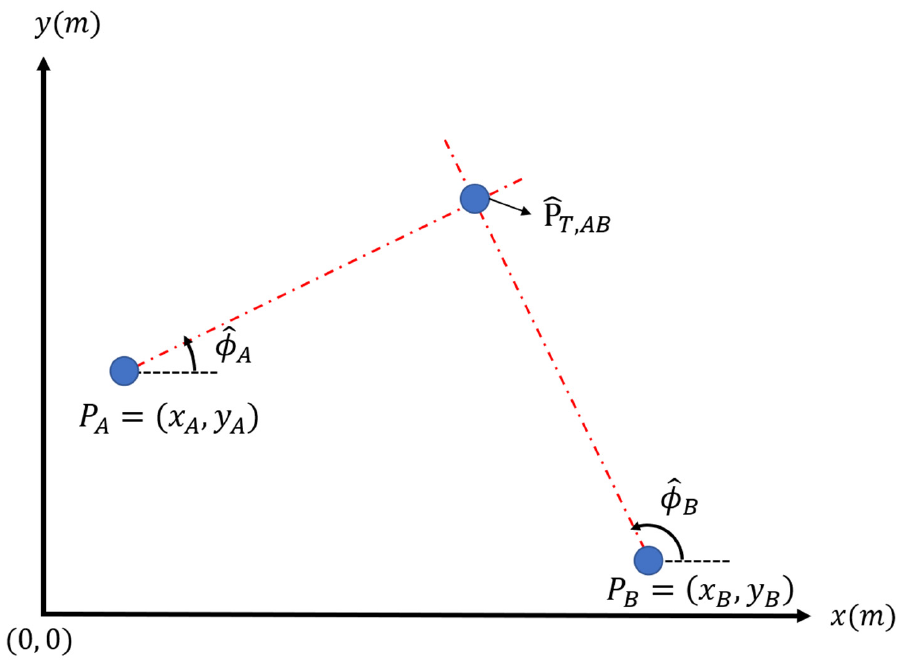
Figure 1. Two-base stations localization system.